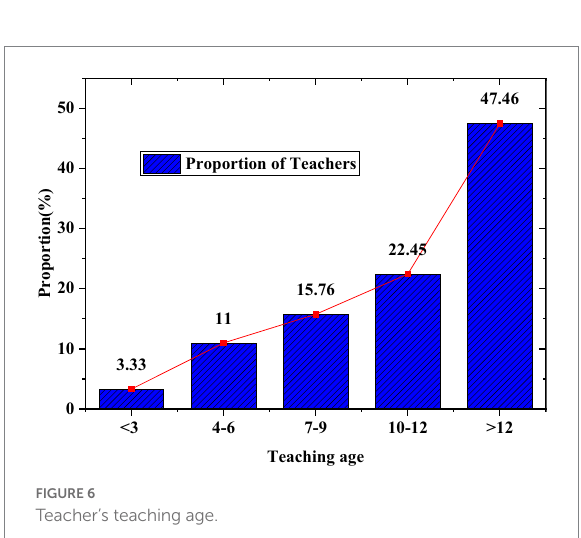
FIGURE 6 Teacher’s teaching